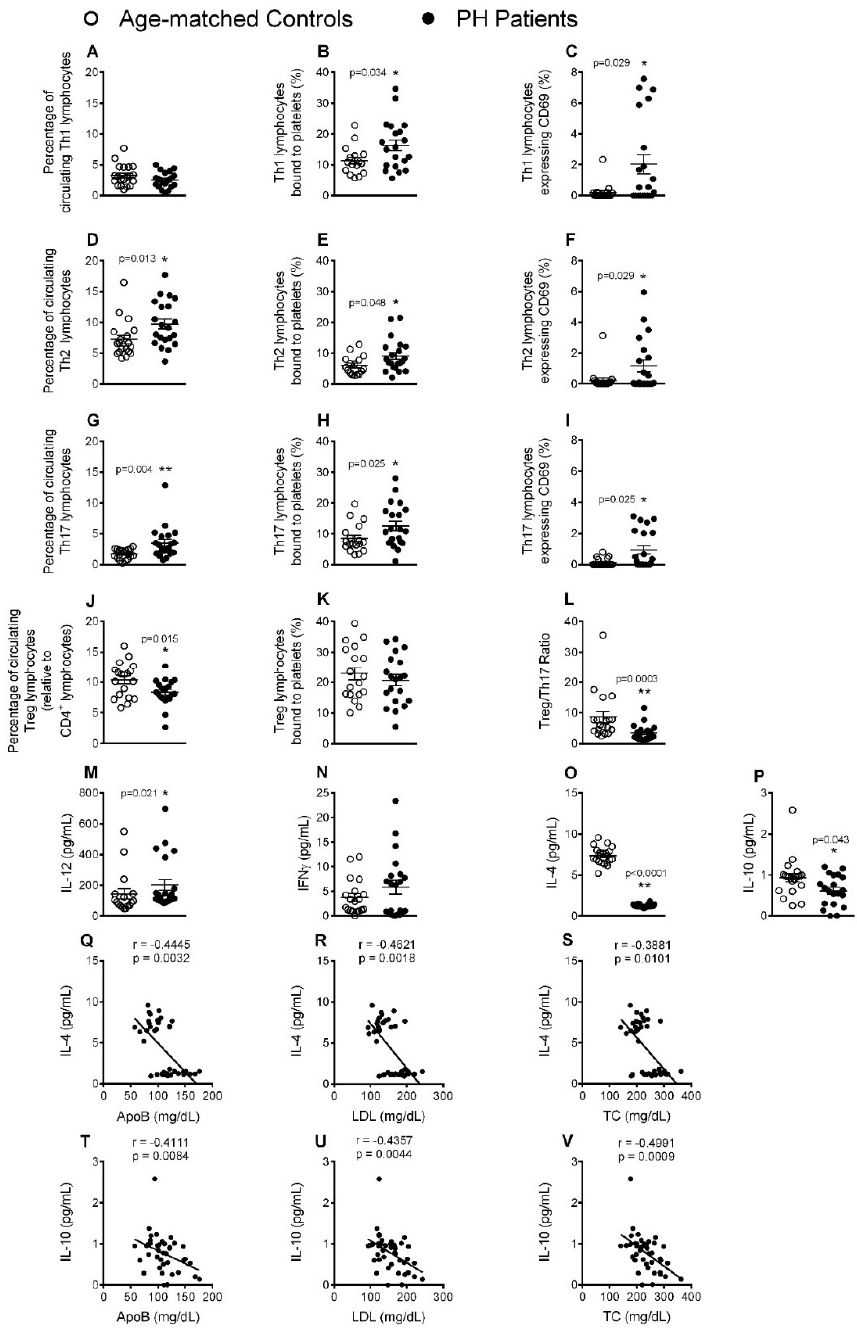
Figure 5. The percentage of circulating Th2 and Th17 lymphocytes, platelet-lymphocyte aggregates, lymphocyte activation and IL-12 circulating levels, are significantly increased in patients with PH, whereas the percentage of circulating Treg cells, Treg/Th17 ratio, and IL-4 and IL-10 plasma levels, are decreased. Heparinized whole blood was co-stained with specific markers for platelets and Th1, Th2, Th17 and Treg lymphocytes ( A , B , D , E , G , H , J and K ) as well as for CD69 ( C , F and I ). Treg/Th17 ratio was also determined ( L ). Results are expressed as percentage of positive cells. IL-12 ( M ), IFNγ ( N ), IL-4 ( O ) and IL-10 ( P ) plasma levels (pg/mL) were measured by ELISA ( n = 21 control subjects and n = 22 PH patients). Values are expressed as mean ± SEM. * p < 0.05 or ** p < 0.01 relative to values in the control group. Correlations between circulating IL-4 or IL-10 and ApoB ( Q and T ), LDL ( R and U ) and TC ( S and V ) plasma levels. 3.5. Circulating Levels of Pro-Inflammatory Cytokines but not Adipokines Are Increased in PH Patients